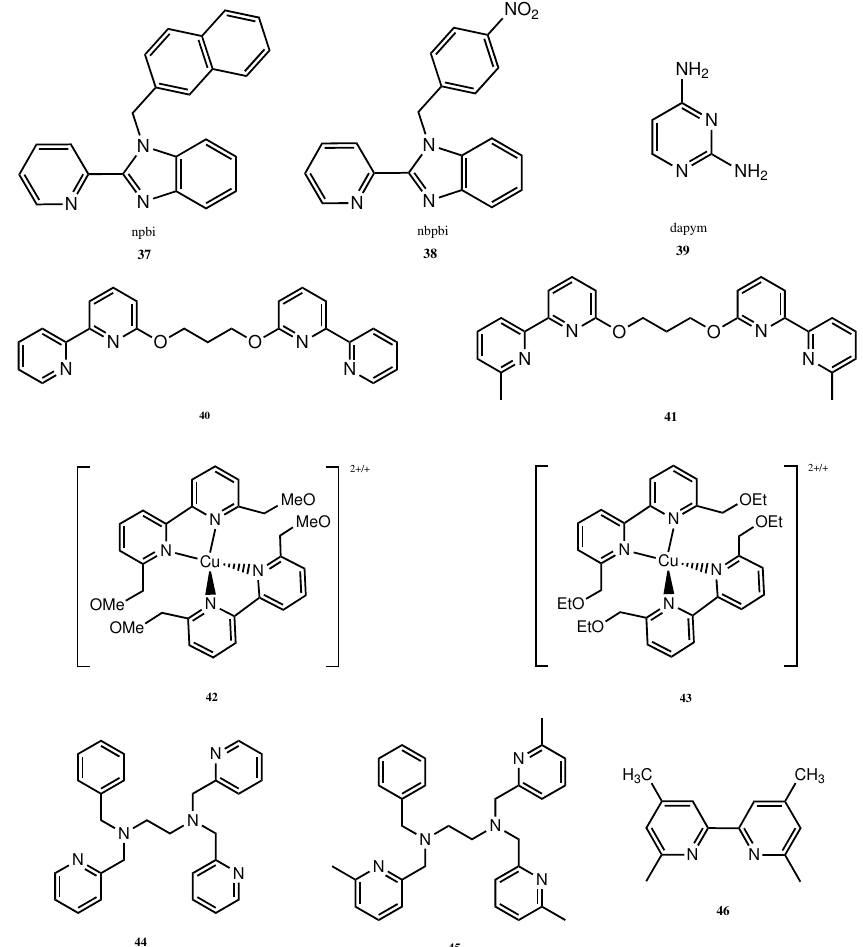
Figure 5. Structures of ligands and coordination compounds used in DSSCs. Reprinted from [30] with permission of